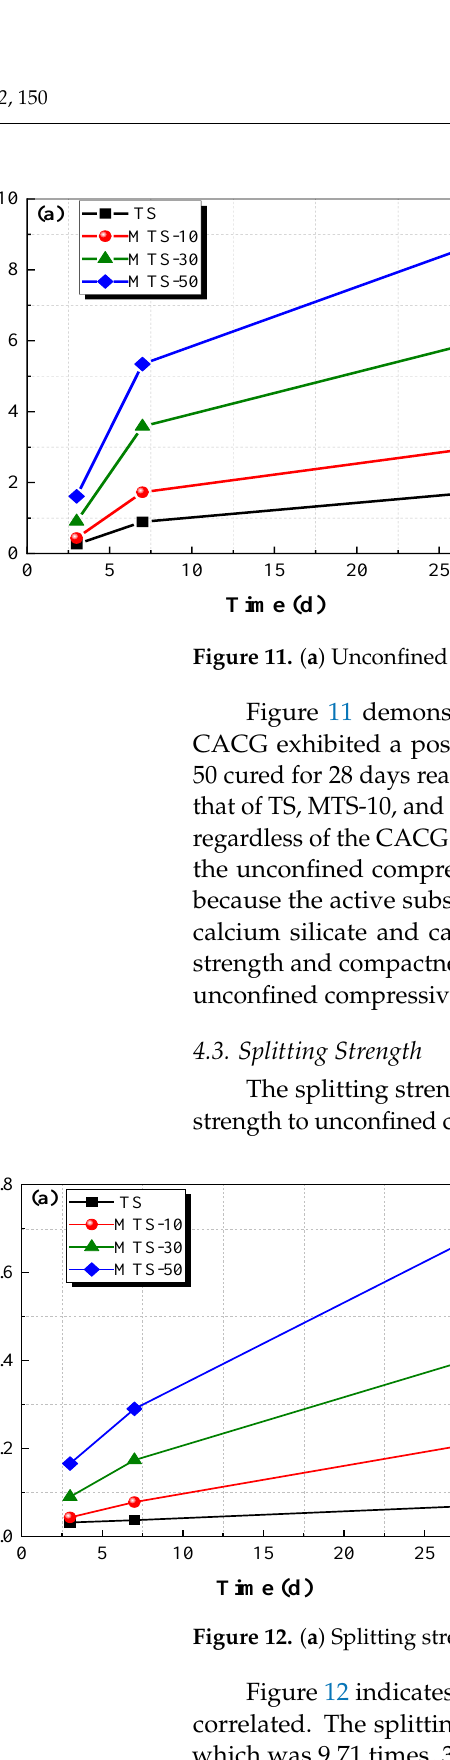
Figure 12. ( a ) Splitting strength of specimens at different curing times; ( b ) relative ratio. Figure 12 indicates that the splitting strength and the CACG content were positively correlated. The splitting strength of MTS-50 cured for 28 days reached up to 0.68 MPa, which was 9.71 times, 3.23 times, and 1.67 times that of TS, MTS-10, and MTS-30, respec- tively. Moreover, the splitting strength increased with the increase in curing time. Because the reaction between coal gangue and Ca(OH) 2 produces hydrated calcium silicate and hydrated calcium aluminate, its bonding performance and strength are higher than cal- cium carbonate, which leads to greater compactness and mechanical properties.